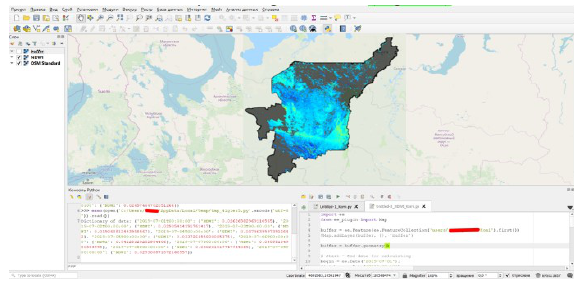
Figure 5. NDWI map for the Komi Republic (March 1,